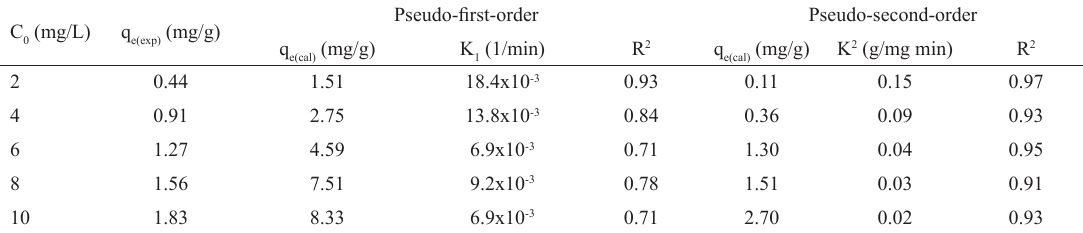
Table 2: Constants and correlation coefficient of two kinetic models for Ag + adsorption onto CTS-3%MMT composite bead at different concentration (adsorbent dose: 1 g; Volume: 100 mL; pH: 6) C (mg/L) q (mg/g) 0 e(exp)